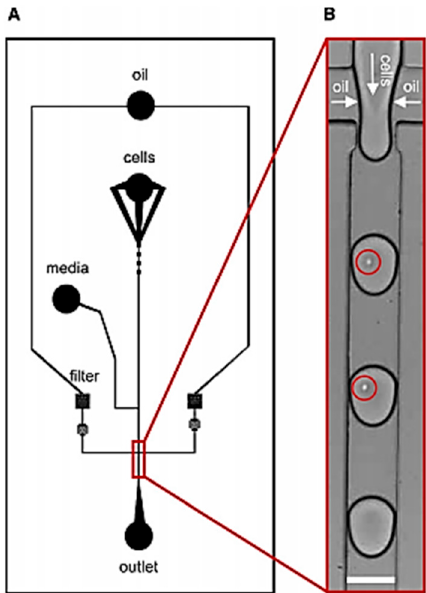
Figure 1. Schematic diagram of the chip proposed by Jenifer et al. ( A ) The bounded rectangle shows the area where droplets containing cells are generated; ( B ) Mechanism of encapsulation of the cells in the aqueous droplets. The red circles highlight the single cells in the droplets. Reprinted with permission from [57].